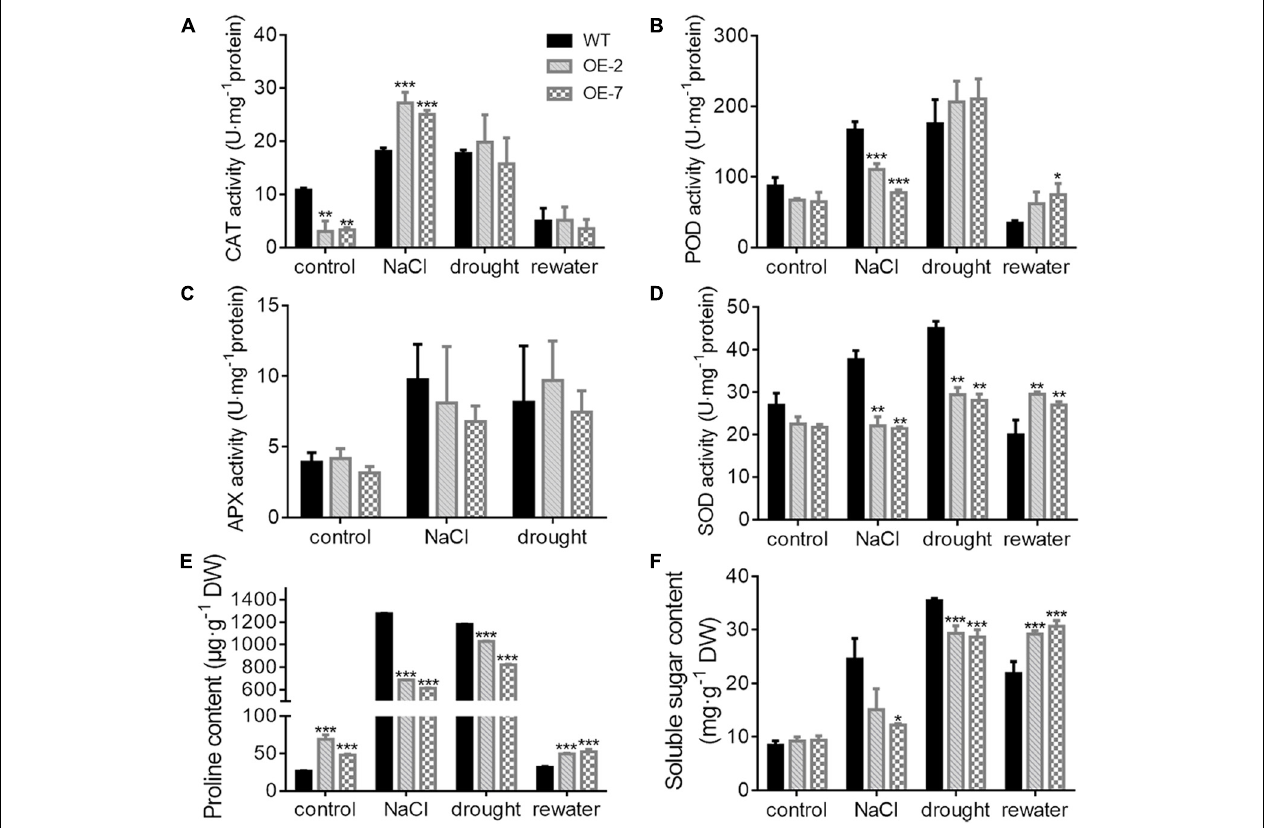
FIGURE 6 | Antioxidant activity and osmotic content in transgenic tobacco under abiotic stress. (A–D) Activities of catalase (CAT) (A) , peroxidase (POD) (B) , ascorbate peroxidase (APX) (C) , and superoxide dismutase (SOD) (D) enzymes after 13 days of treatment with 200 mM NaCl, 10 days of drought and 4 days of post-drought rewatering. The activity units are expressed as U · mg − 1 protein. CAT activity was calculated by following the breakdown of H 2 O 2 . POD activity was calculated by following the guaiacol oxidation. APX activity was calculated by following the ascorbate oxidation. SOD activity was calculated by monitoring the superoxide radical-induced reduction of nitro blue tetrazolium (NBT). One unit of enzyme activity was defined as the amount of enzyme causing 50% inhibition per mg of protein. (E) Proline content, (F) Soluble sugar content. At least three biological replicates were included. Asterisks indicate significant differences between the transgenic and WT lines ( t -test, * P < 0.05, ** P < 0.01, *** P <